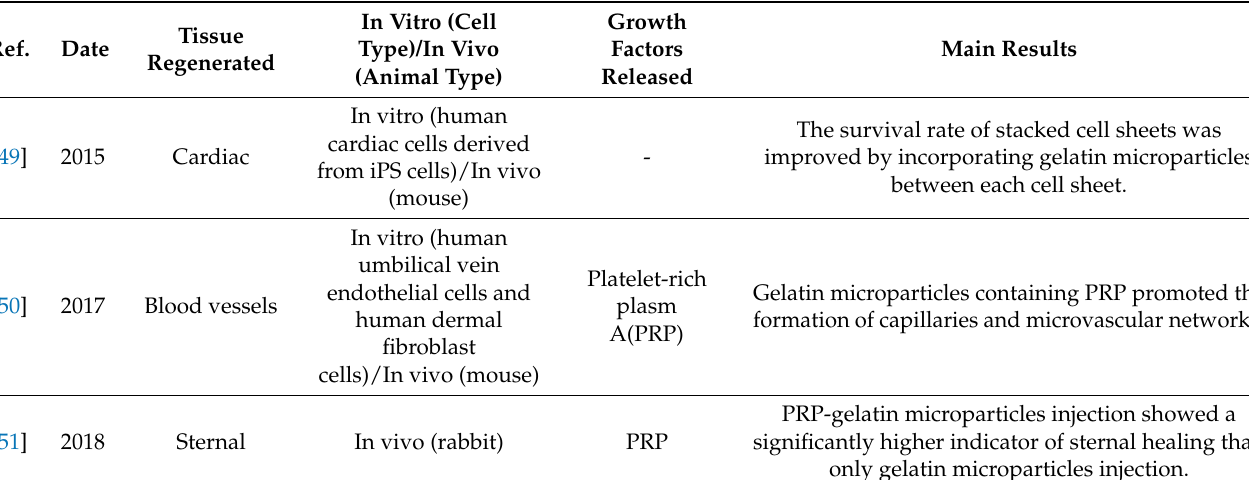
Table 2. Examples of regenerative therapy and tissue regeneration strategies using gelatin microparticles.